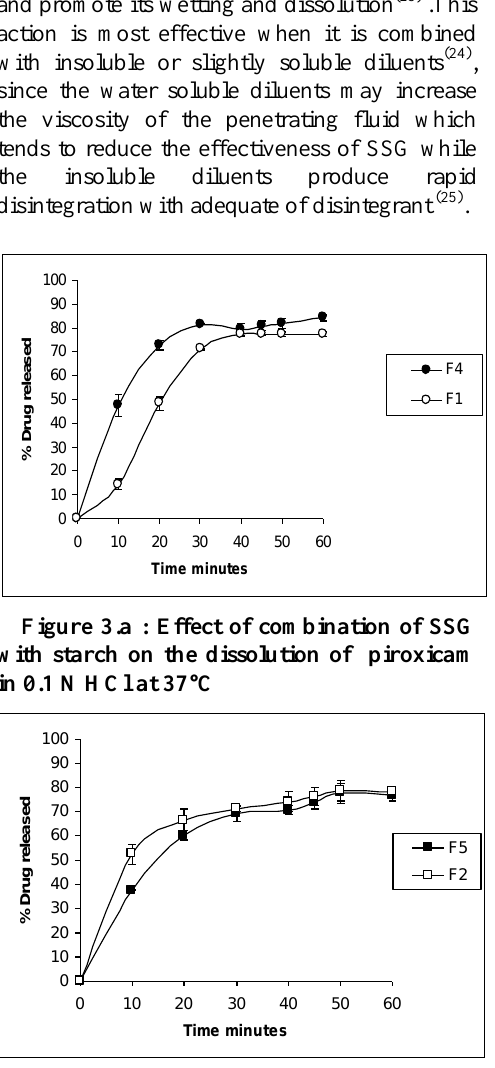
Figure 3.b: Effect of combination of SSG with lactose on the dissolution of piroxicam in 0.1 N HCl at 37°C